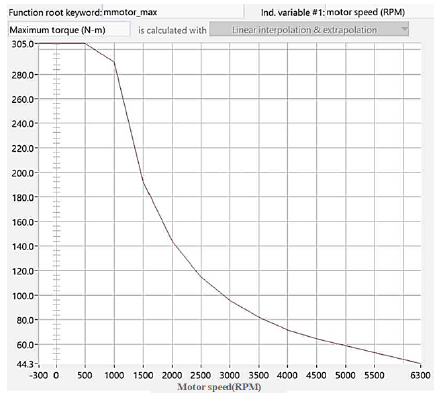
Figure 14. Motor torque